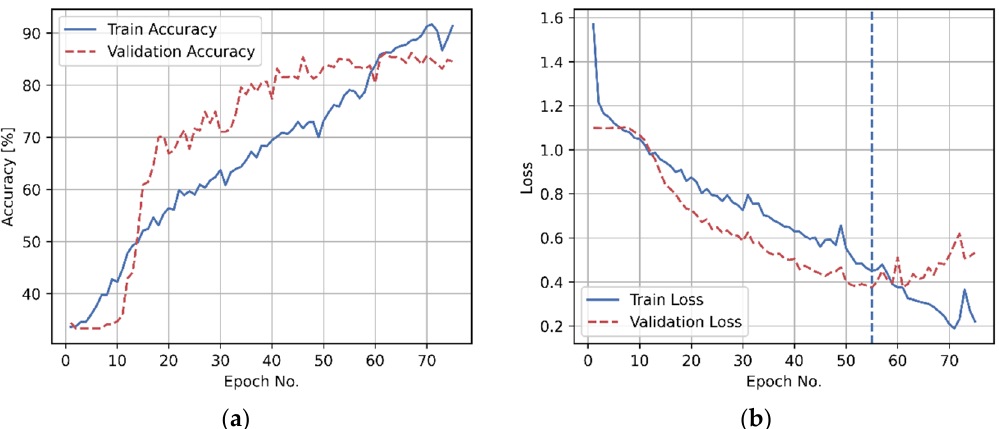
Figure 6. Example learning curves of the convolutional neural network: ( a ) accuracy; ( b ) loss. A vertical blue line denotes the training termination point.